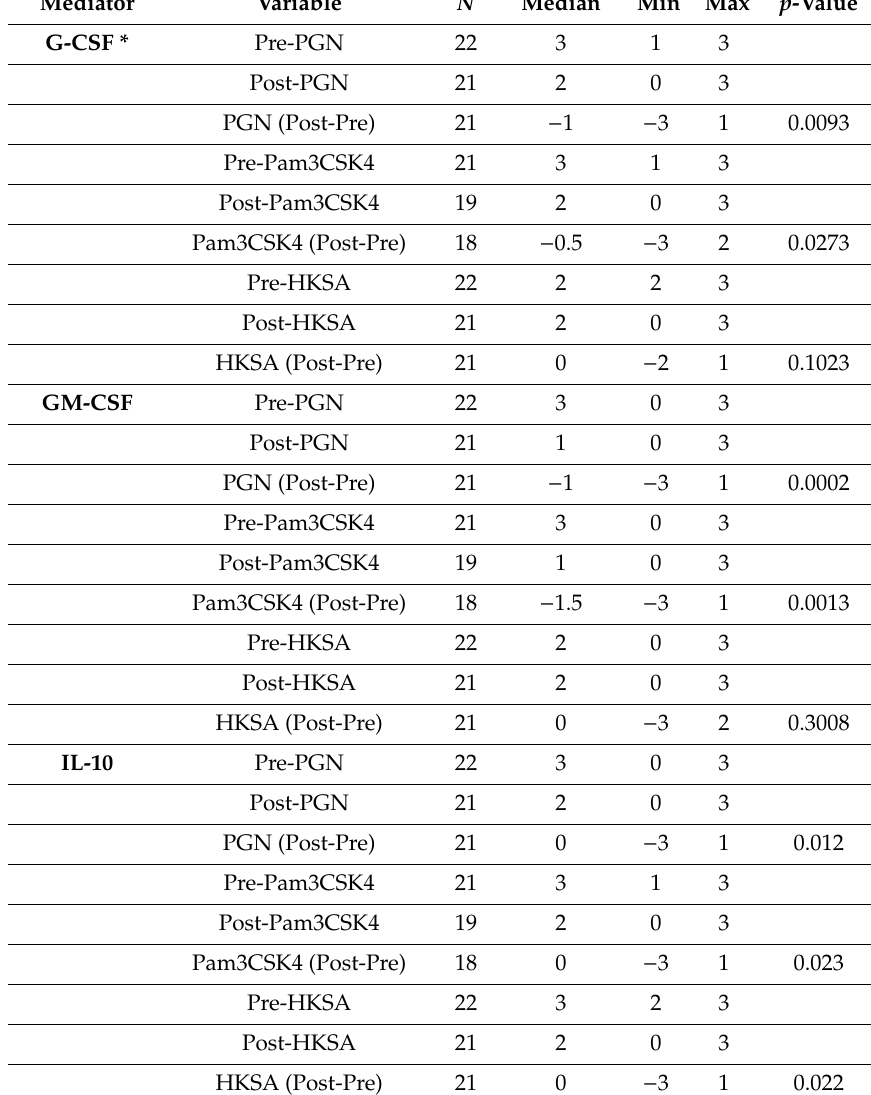
Table 5. Mediators increased in PBMCs following spinal